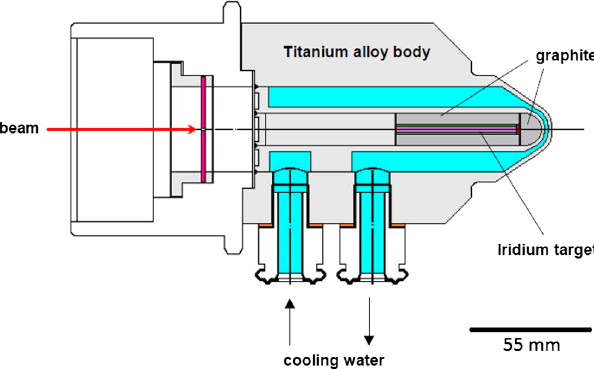
FIG. 1. Schematics of the water cooled antiproton target design used from 1987 to present